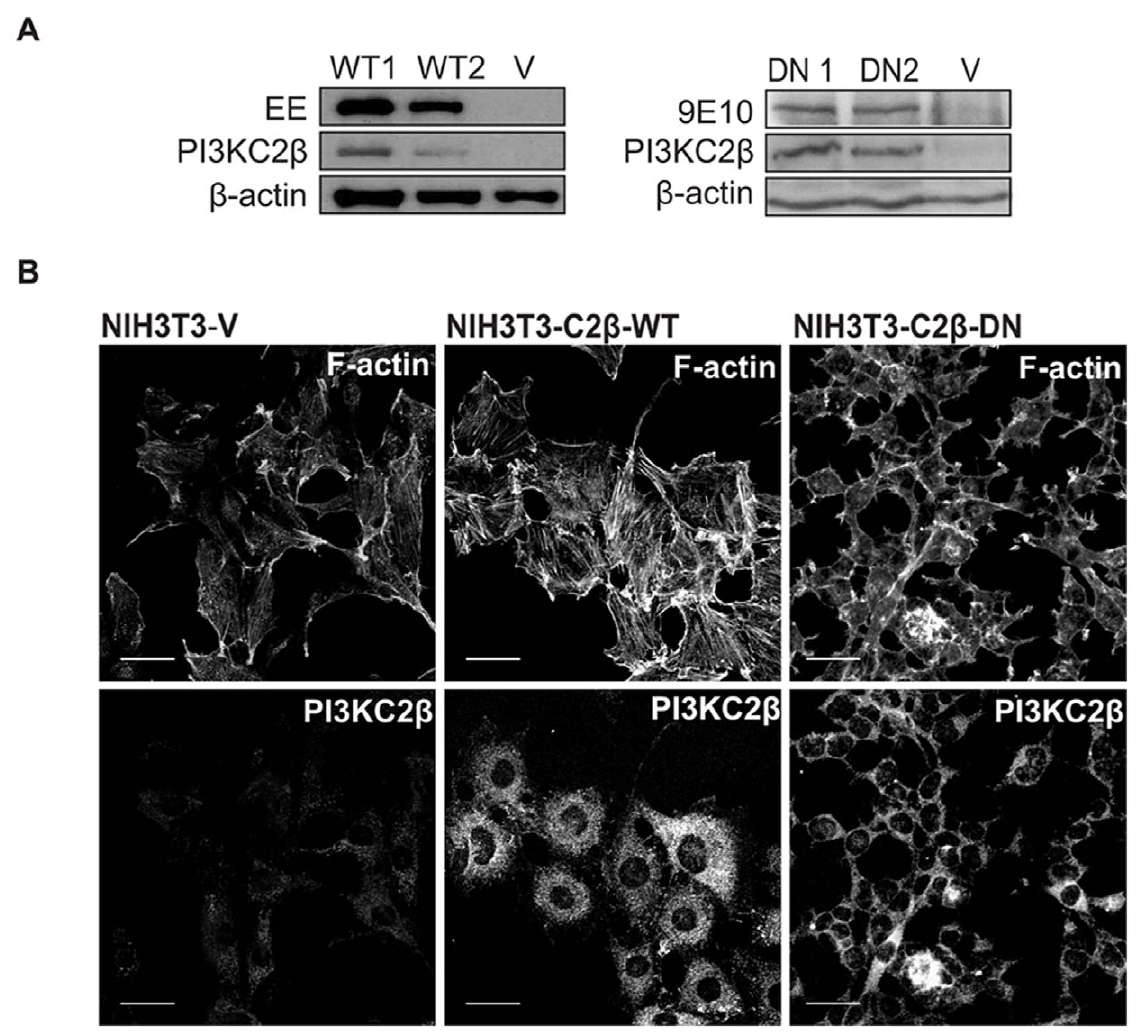
Figure 3. Kinase-dependent PI3KC2 b effect on cytoskeletal rearrangements. (A) Cell lysates of NIH3T3 cells stably expressing empty vector (NIH3T3-V), kinase-dead (D1213A) dominant-negative Myc-PI3KC2 b (NIH3T3-C2 b -DN) and wild-type Glu-PI3KC2 b (NIH3T3-C2 b -WT) were analysed for the recombinant PI3KC2 b expression by immunoblotting with the indicated antibodies (EE: Glu-tag, 9E10: Myc-tag). (B) Confocal images of NIH3T3-V, -C2 b -WT and –C2 b -DN cells grown on cover slips for 24 h in 10% FCS and stained with Alexa Fluor 555 dye to localise F-actin, and an anti-PI3KC2 b antibody follwed by FITC-labelled anti-rabbit antibody, to localize the kinase. WT1, WT2 and DN1, DN2 indicate individual clones. Scale bar represents 40 m